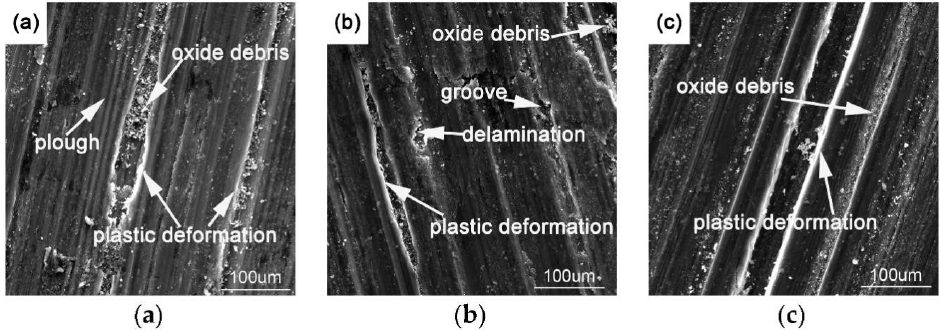
Fig. 5 SEM photos of the impact fractures of heat-treated samples of different